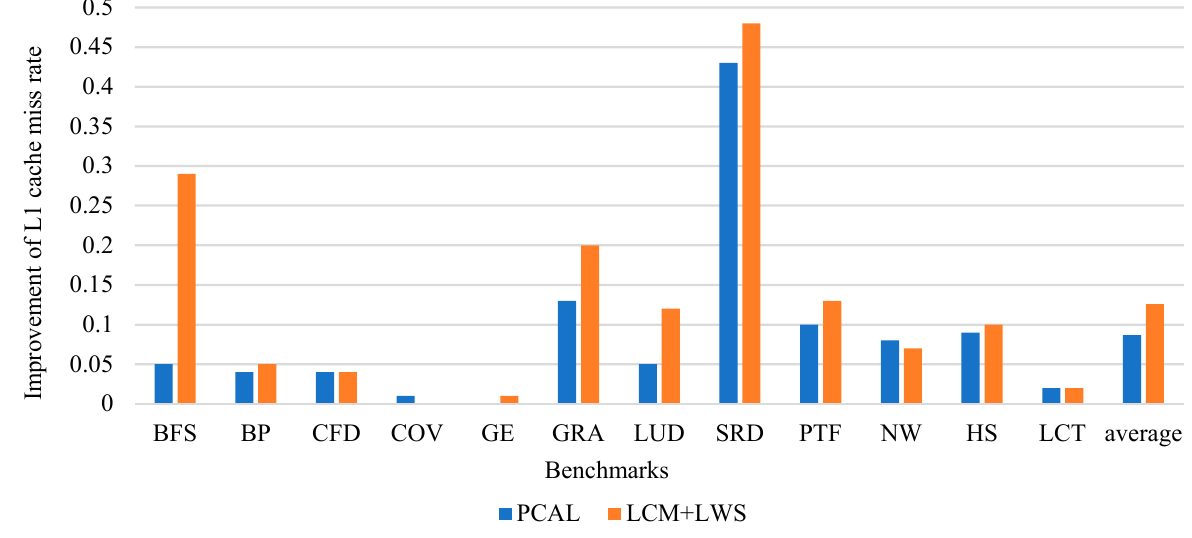
Figure 7. Reduction in the miss rate of LCM for the L1 data cache.